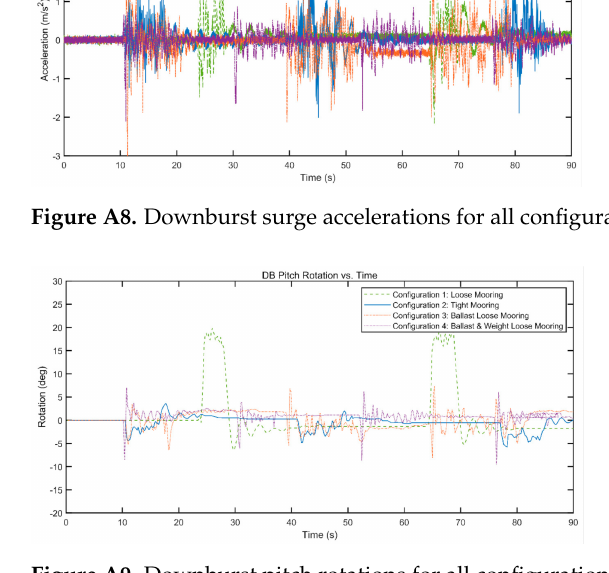
Figure A9. Downburst pitch rotations for all